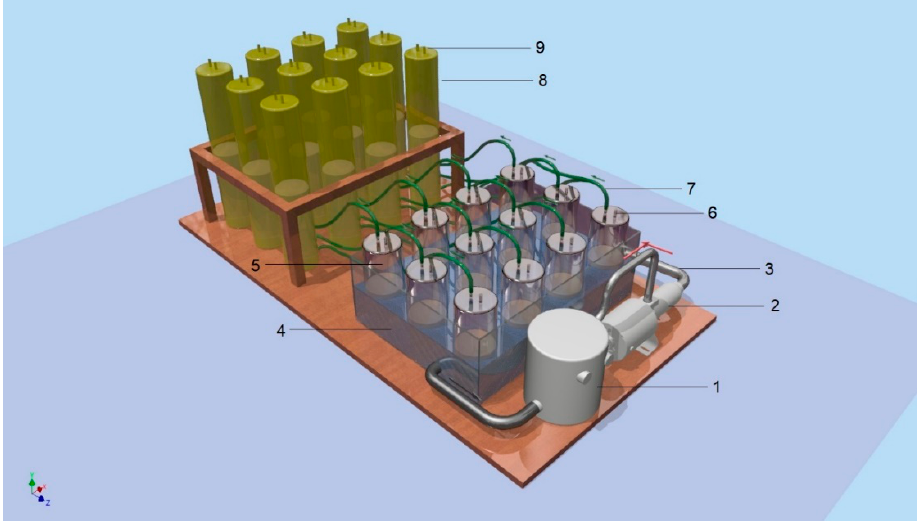
Figure 1. The biofermenter used in biogas production tests (18-chamber section); 1—water heater